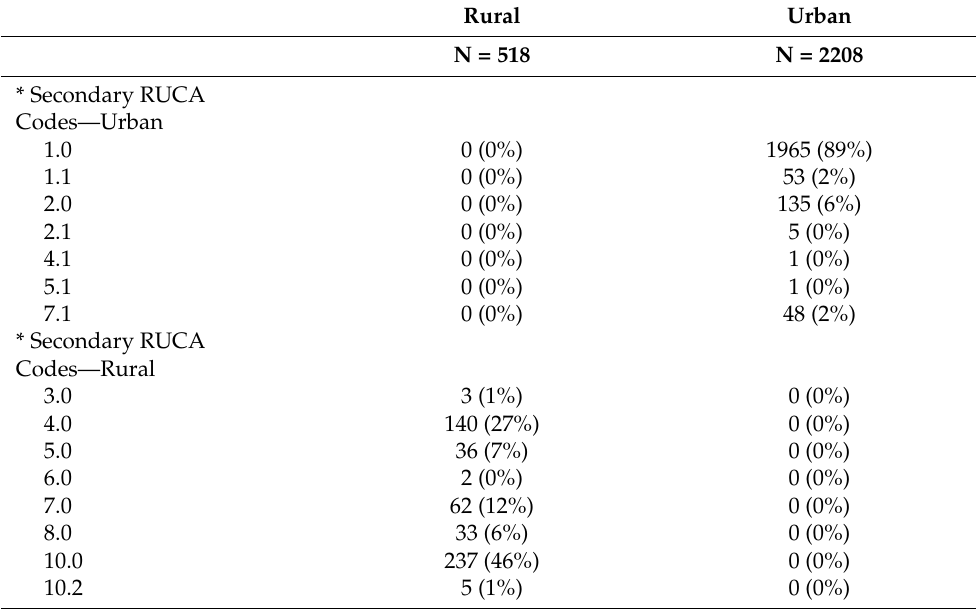
Table 1. Distribution of participants categorized as urban vs. rural across secondary RUCA codes,